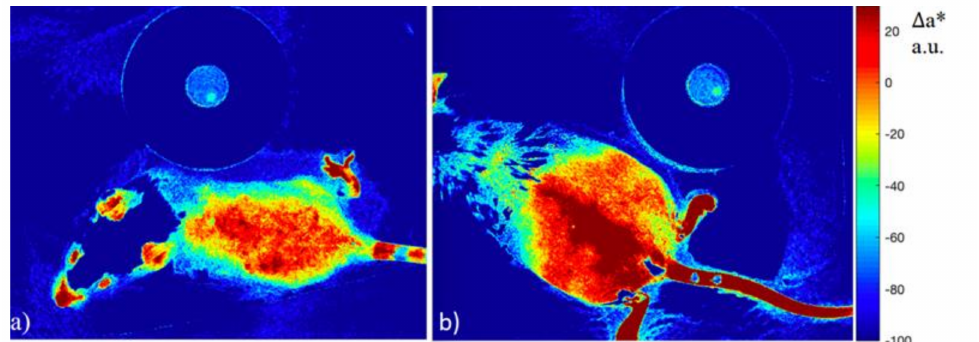
Figure 6. The results of ∆ a* calculation for a mouse from the group that received a dose of 9450 mJ/cm 2 prior to irradiation ( a ), and on the day after irradiation ( b